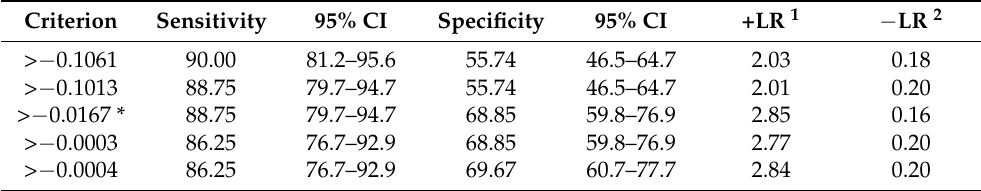
Figure 4. Receiver operating characteristic (ROC) curve showing the performance of the BTV analyte in the BTV/EHDV duplex FMIA at all classification thresholds. The area under the curve (AUC) of 0.785 ( p < 0.001) gave an acceptable relationship [51] between the ability of the FMIA to detect BTV antibody-positive samples when compared to the BTV cELISA. Table 1. Sample value/positive value (S/P) criterion of positivity (> − 0.0167 *) for the BTV analyte in the BTV/EHDV duplex FMIA. MedCalc was used to determine sensitivity and specificity at a 95% confidence interval